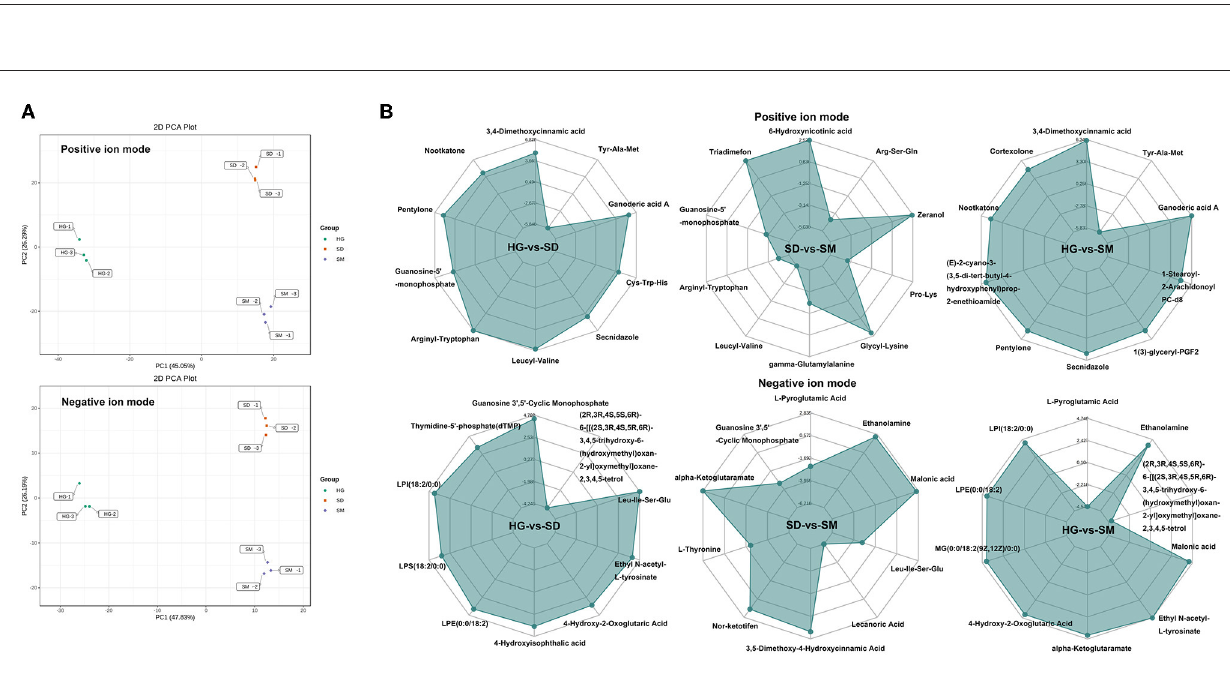
FIGURE4 PCA analysis and differential accumulated metabolites (DAMs) analysis. (A) PCA analysis of the samples in the three development stages at the positive and negative ion modes. (B) Radar chart of significant DAMs in the three compared groups at the positive and negative ion